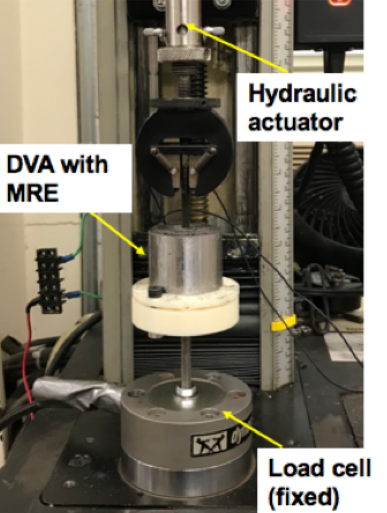
Figure 5: Experimental setup for the damper force testing of the MRE-based DVA. Figure 6. Experimental setup for the damper force testing of the